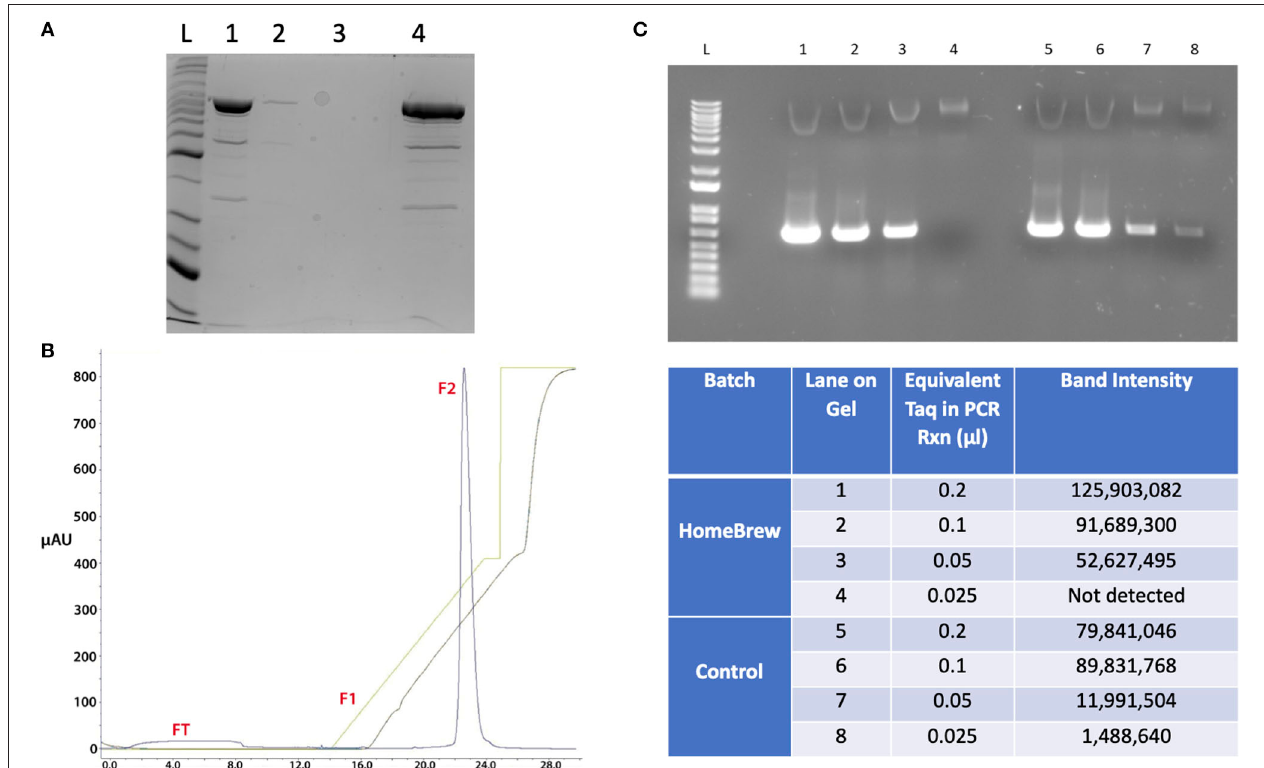
FIGURE 6 | Purification and enzyme activity for HB Taq. (A) SDS Page showing 0.16mg protein for MonoS fractionation prior to sample fractionation (Lane 1), the FT fraction (Lane 2), F1 (Lane 3) and F2 (Lane 4) fractions. (B) mAU readings for fractions FT, F1 and F2 from MonoS purification column. (C) Titration of HB Taq activity relative to a control enzyme using end-point PCR and gel image intensity: 0.2 µ l enzyme (lane 1 and 5); 0.1 µ l enzyme (lane 2 and 6); 0.05 µ l enzyme (lane 3 and 7); 0.025 µ l enzyme (lane 4 and